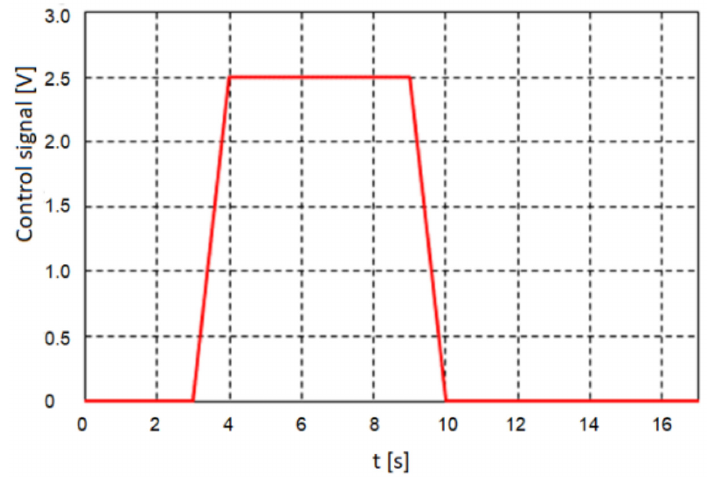
Figure 14. Waveform of the control signal. The performed tests showed that the converter input voltage and the motor phase-to- phase voltages practically did not change with pressure changes, and therefore they were not included in the article. This proves that the converter and the motor can be loaded with more power than that required by the hydraulic system during the measurements. The converter input currents for the speeds of 1000 and 1500 rpm are presented, respectively, in Figure 15, while the phase currents of the motor-pump assembly are shown in Figure 16.